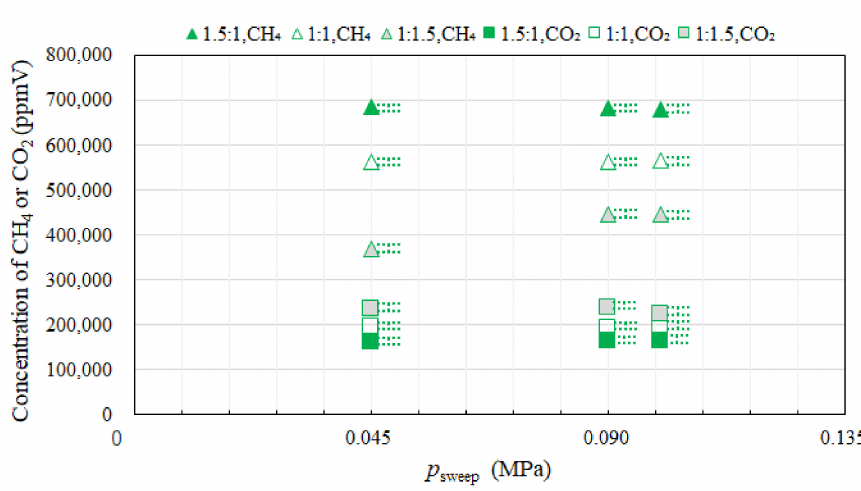
Figure 6. Impact of concentrations of CH 4 and CO 2 at the outlet of reaction chamber on p sweep with changing molar ratios of CH 4 :CO 2 .